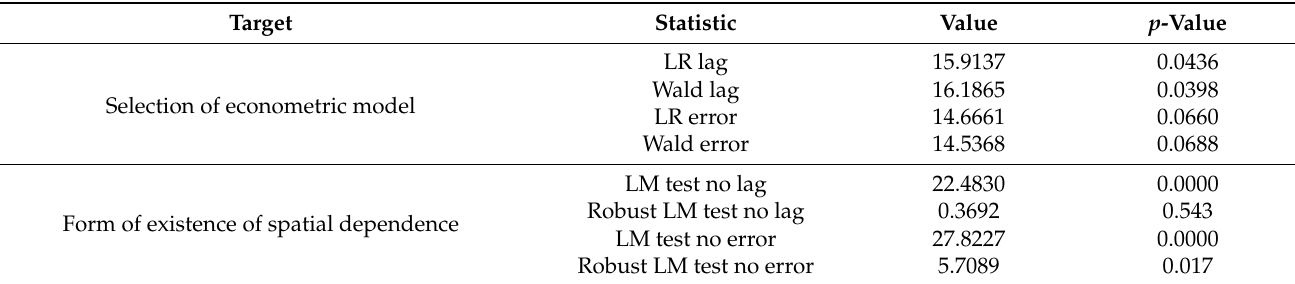
Table 5. Spatial panel econometric model